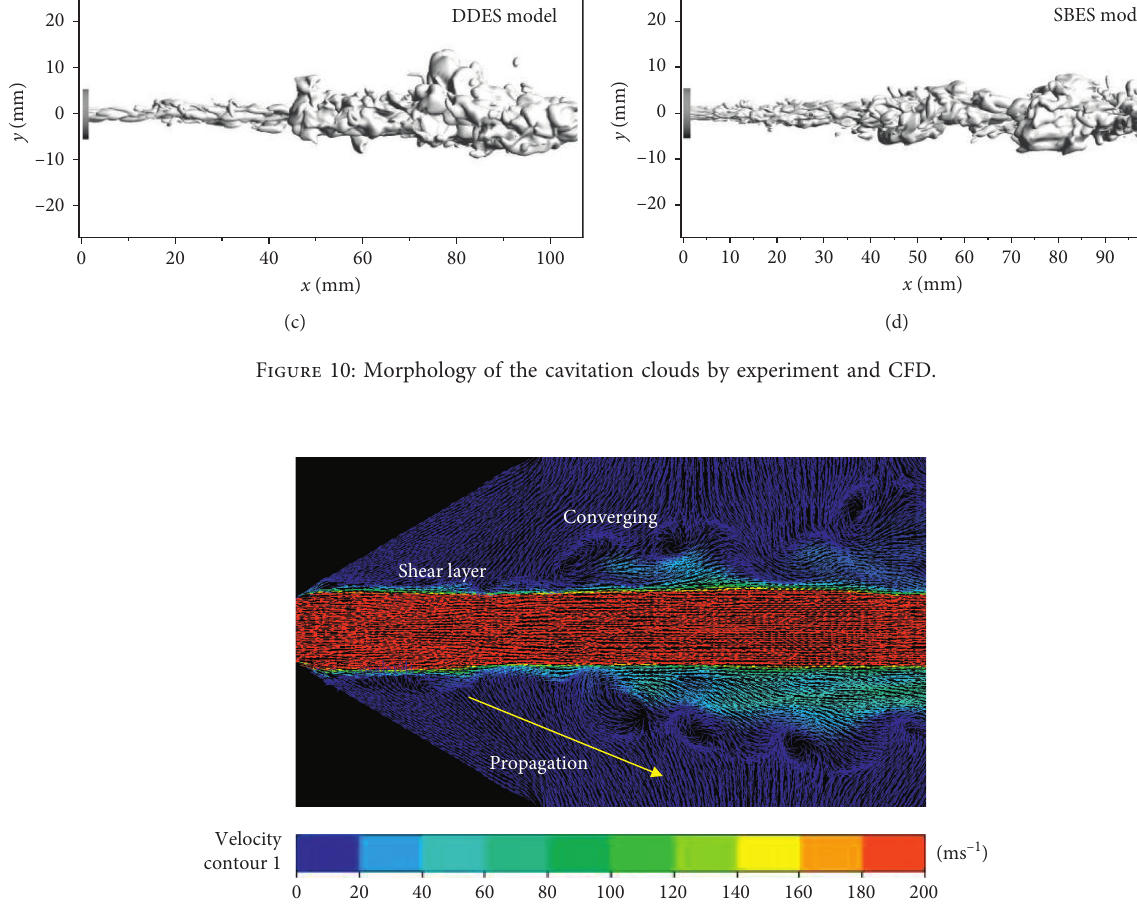
Figure 11: Vortex structure of the jet by a convergent-divergent